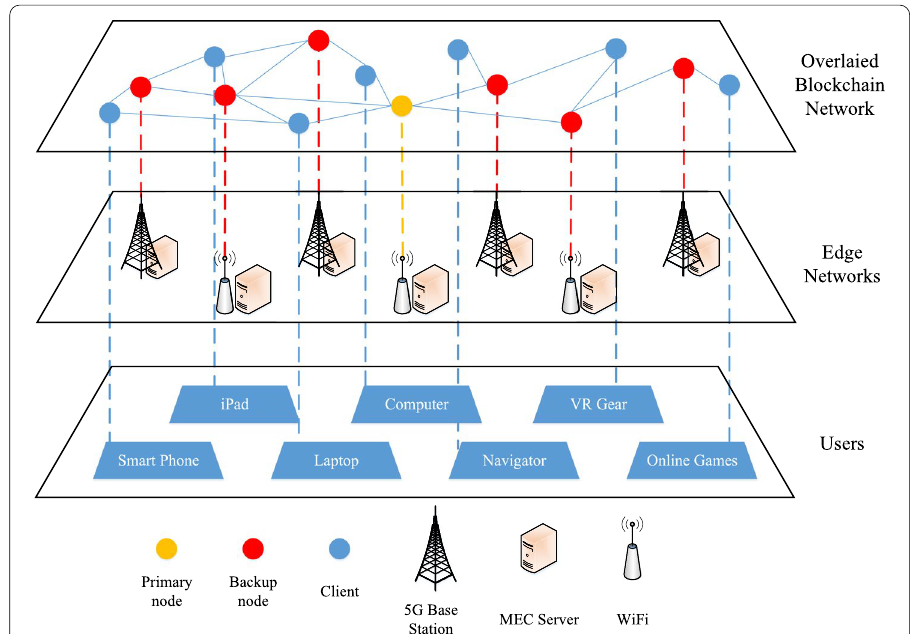
Fig. 6 BMEC in the heterogeneous wireless networks; Illustration of the BMEC in the heterogeneous wireless